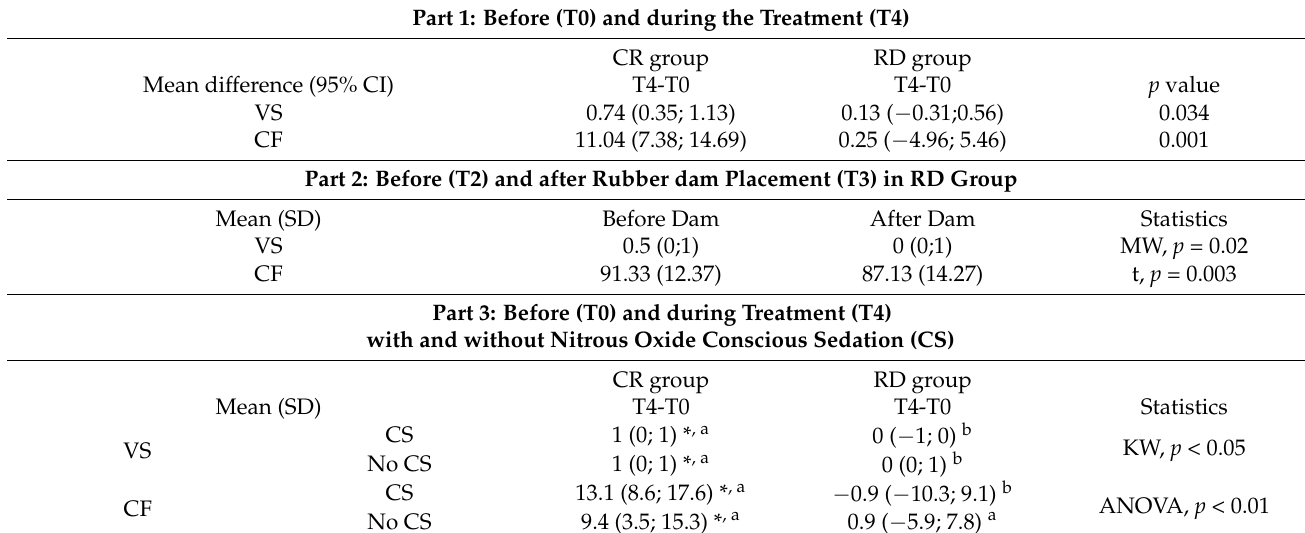
Table 2. Behavior according to Venham (VS) and Cardiac frequency (CF) comparisons for subgroups undergoing procedures with or without conscious sedation. p -value concerns CR and RD groups for part 1 and 3 and before and after rubber dam placement in RD group fort part 2 according to t Student